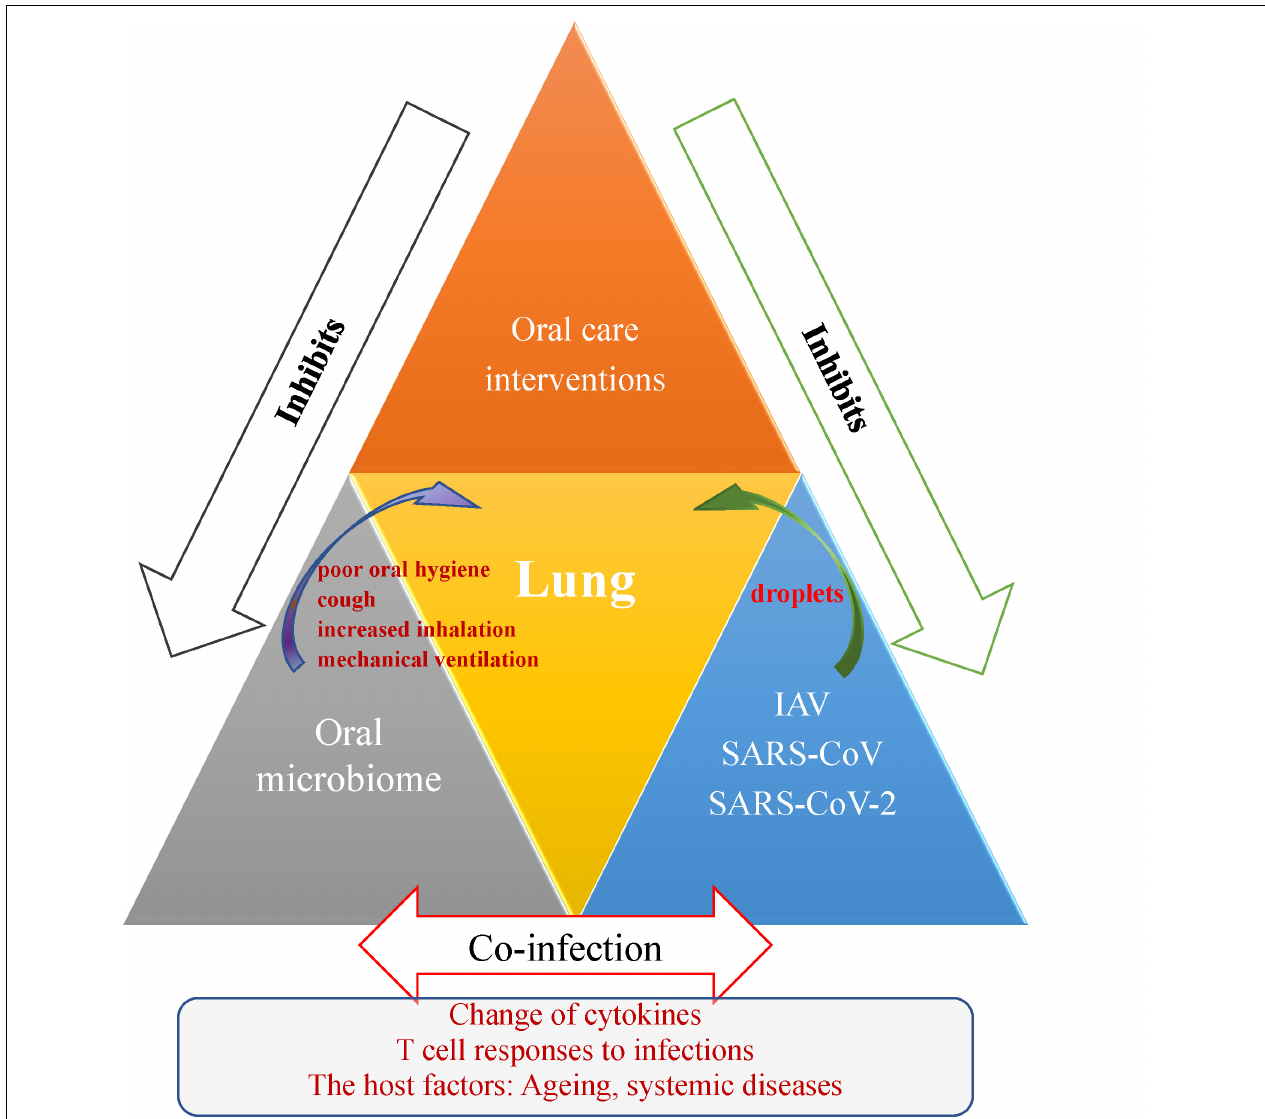
FIGURE 1 | Schematic representation outlining the oral-lung-axis mechanism of viral-bacterial lung co-infection during respiratory viral infections and effect of the oral care interventions for patients. Risk factors such as poor oral hygiene, cough, increased inhalation and mechanical ventilation provide a pathway for oral microorganisms to enter the lower respiratory tract and thus cause co-infection to aggravate respiratory disease via mechanisms involving changes in cytokines, T cell responses, and the effects of host conditions such as aging and the oral microbiome changes due to systemic diseases. Improving oral hygiene care by either mechanical or chemical control of dental plaque biofilm formation would reduce the number of potential respiratory pathogens and inhibit droplet-borne virus route through oral cavity, and hence consequently reduce the risk and mortality risk of aspiration